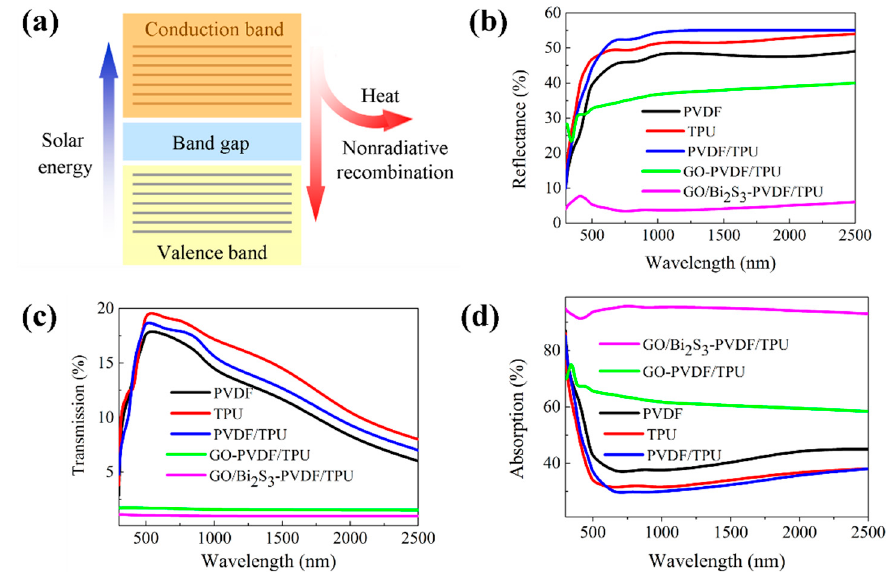
Figure 7. The mechanisms of light absorption and photothermal conversion ( a ), UV-Vis-NIR transmittance ( b ), and reflectance ( c ) and absorption ( d ) spectra of different membranes.